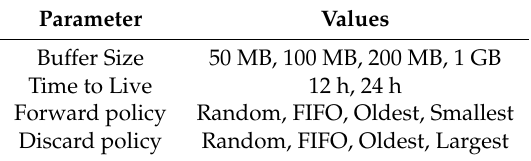
Table 1. Simulation parameters varied to evaluate queue management